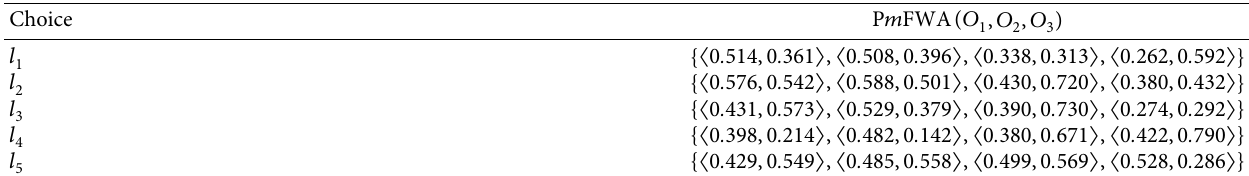
,O ,O ) for each choice. 1 2 3